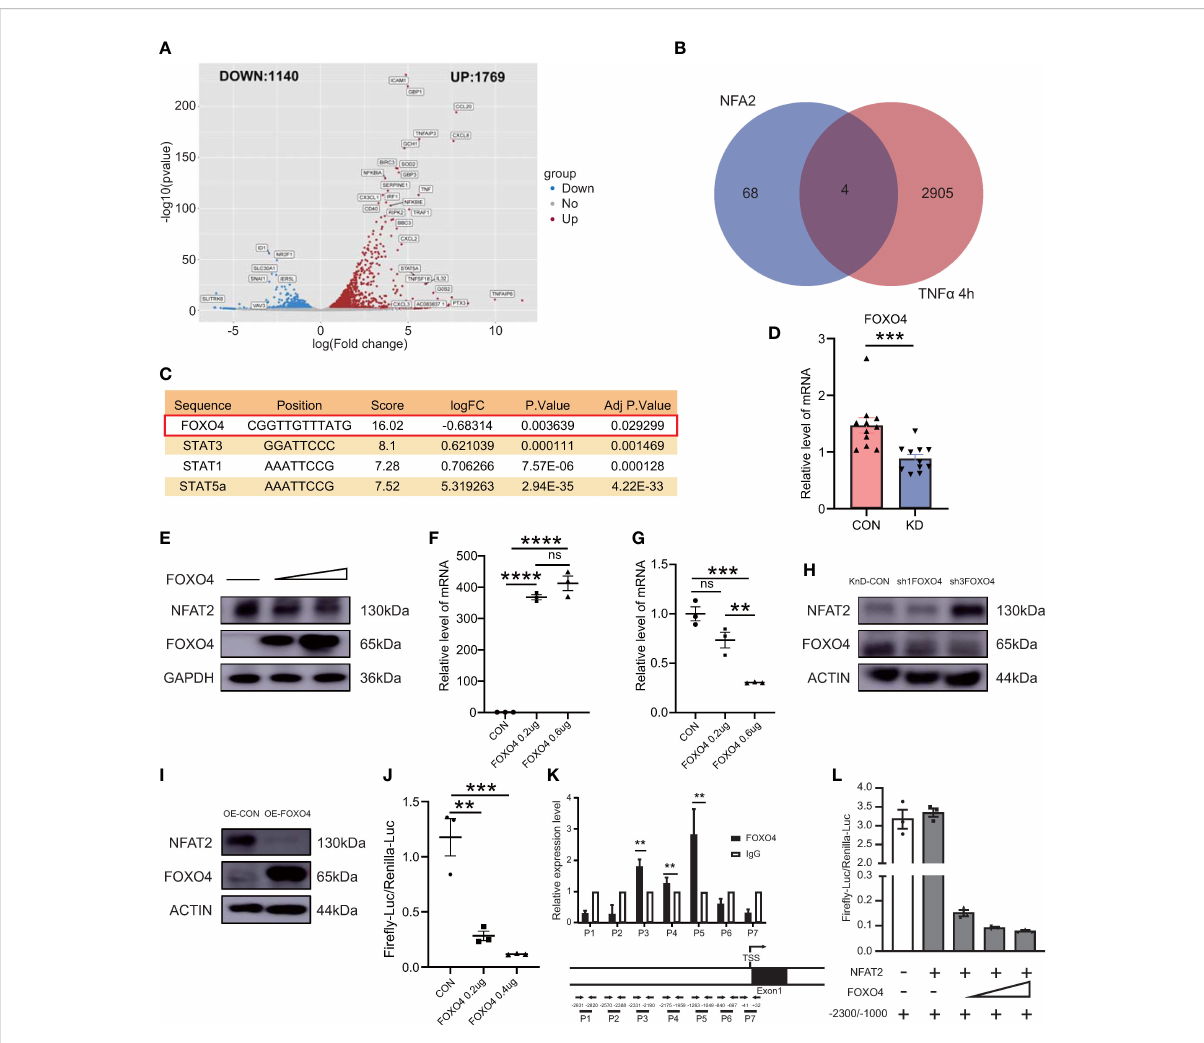
FIGURE 3 FOXO4 negatively regulates NFAT2 by inhibiting its transcription binding to its promoter in vitro . (A) Volcano plot map of differentially expressed genes (DEGs) in HCAECs stimulated by TNF a (40ng/ml) for 4 hours. Red dots, upregulated genes; blue dots, downregulated genes. (B) Venn diagram displaying the overlapping genes between the DEGs in (B) and target genes predicted to have NFAT2 binding sites in their promoter